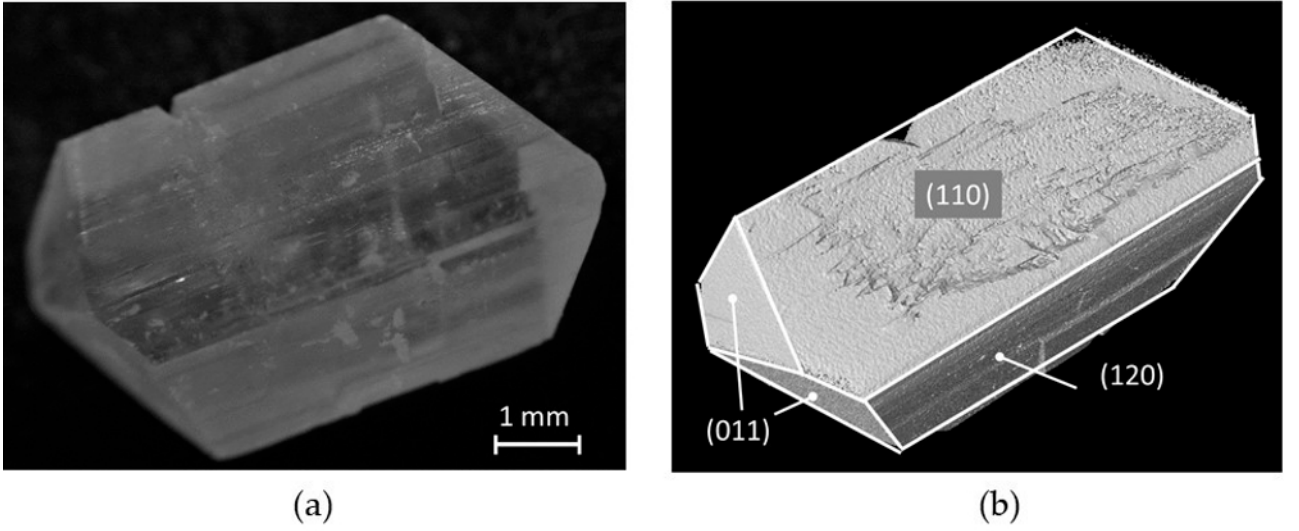
Figure 3. Typical α -glycine crystal: ( a ) photography, ( b ) µ -CT image with indexed crystal